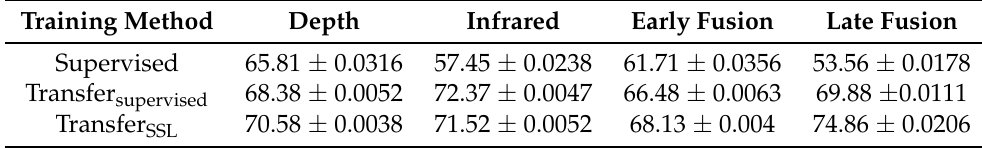
Table 2. Validation accuracy on 100% of training data (unit: %).